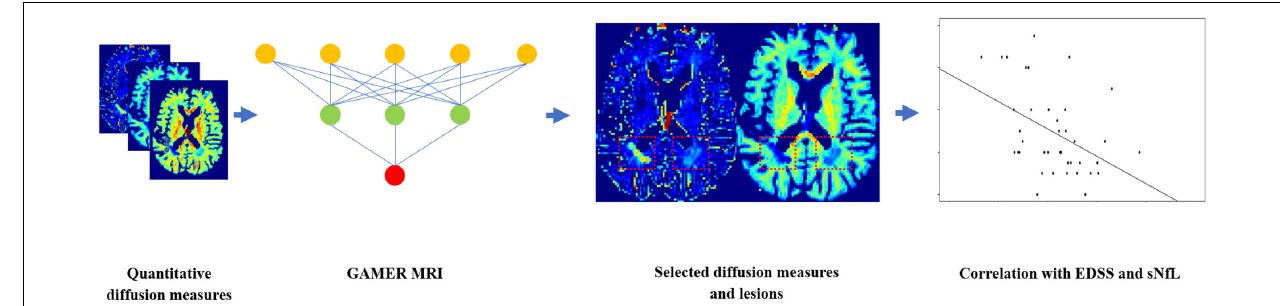
FIGURE 3 | Flowchart for using GAMER-MRI to select the most discriminating subject-wise normalized diffusion measures and correlating the combinations of selected diffusion measures with the Expanded Disability Status Scale and the serum level of neurofilament light chain.